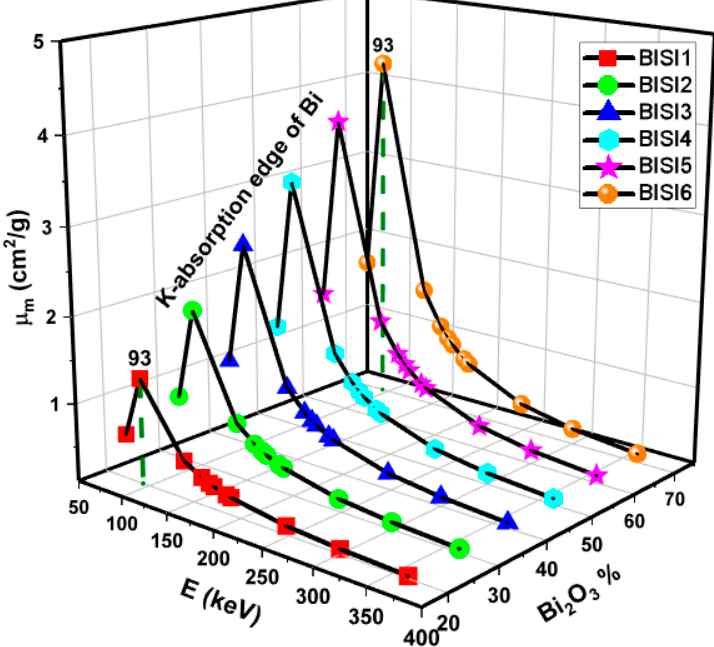
Figure 2. Mass attenuation coefficient ( µ m ) values as a function of photon energy and Bi 2 O 3 content of glass samples.